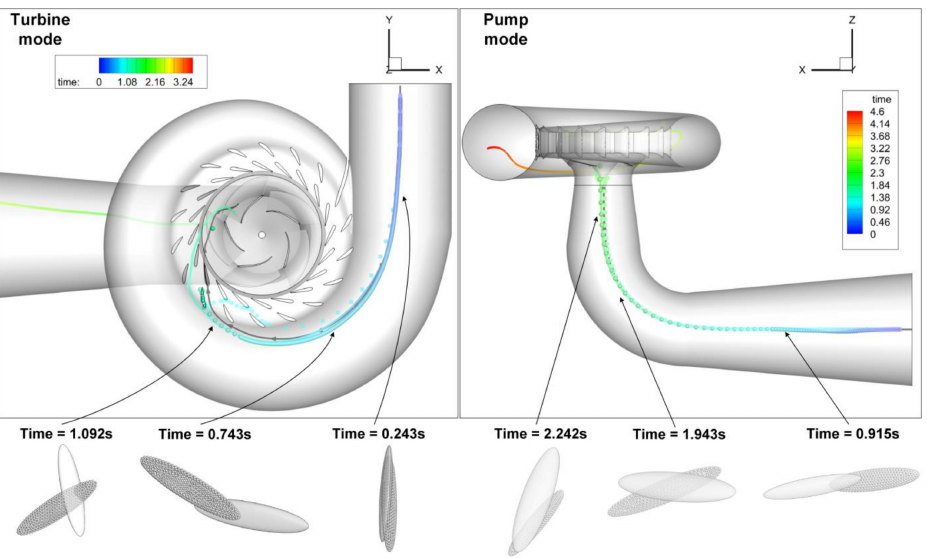
Figure 10. Comparison of fish tracks predicted with different models. Continuous colored line corresponds to the uncoupled 6-DoF. Spheres are positions predicted with overset 6-DoF (spheres are markers, not the body shape). Squares are positions predicted with unsteady particle tracking. Black line with vectors is a streamline for reference. The bottom row shows the position and orientation predicted by the fast-tracking 6-DoF approach (grey spheres), compared with the surface from overset